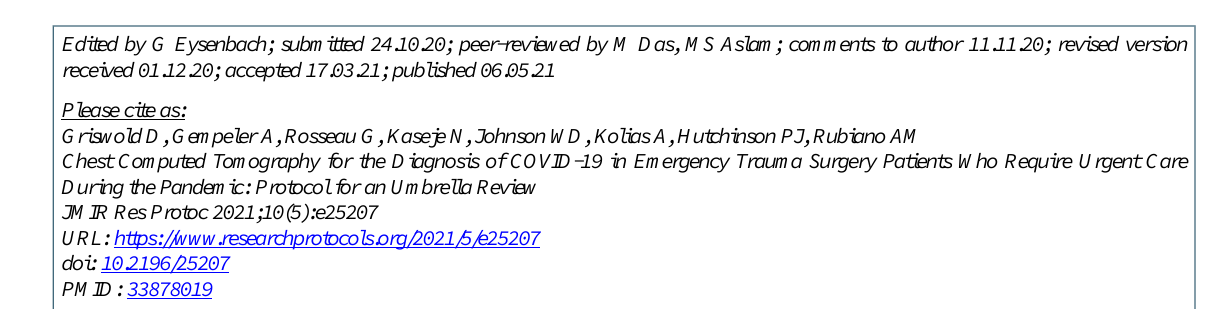
an open-access article distributed under the terms of the Creative Commons Attribution License (https://creativecommons.org/licenses/by/4.0/), which permits unrestricted use, distribution, and reproduction in any